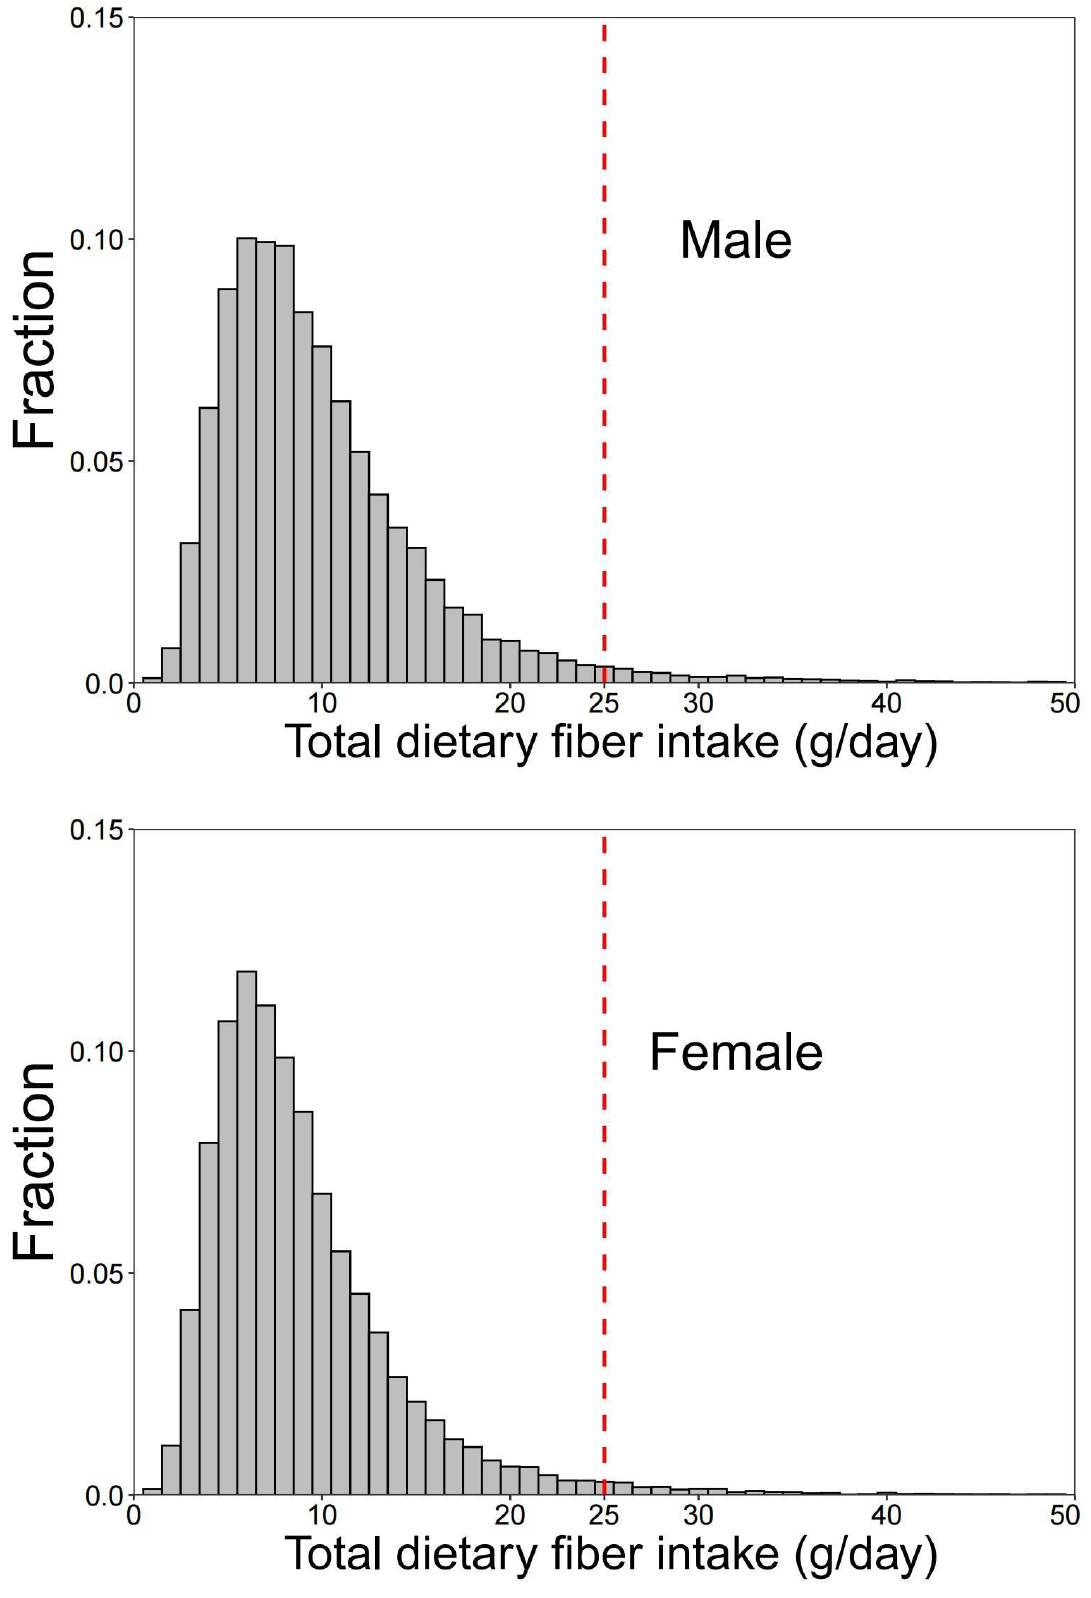
Figure 2. Distribution in intake of total dietary fiber among 66,427 participants aged 18 years and above, CACDNS 2015. The red-dashed line indicates the recommended daily fiber intake of 25 g/day.